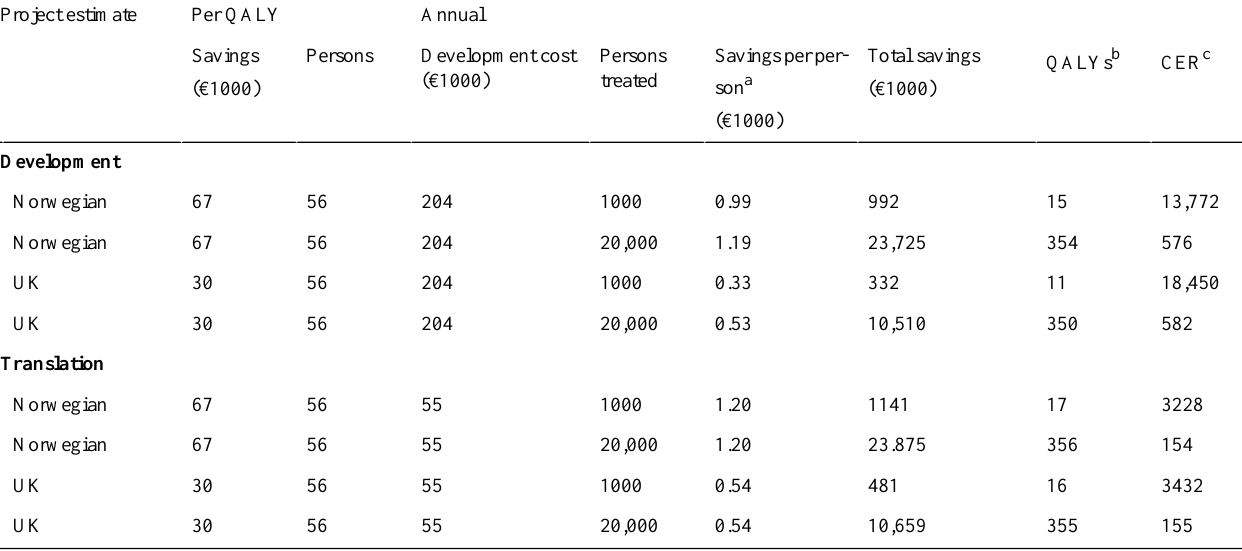
Table 7. Estimates for cost and annual savings (based on 3 years’ operating time) for development and translation projects, with cost-effectiveness ratio